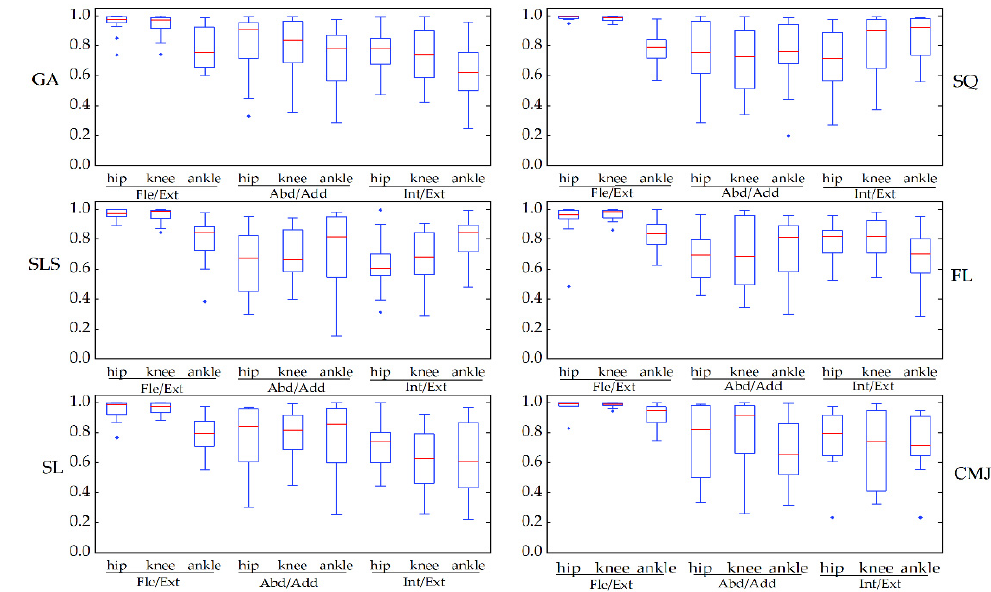
Figure 6. The waveform similarity between Perception Neuron ® system and OptiTrack system data after offset removal (CMC2) was assessed using box-and-whiskers plots of CMC values in the gait (GA), squat (SQ), single-leg squat (SLS), side lunge (SL), forward lunge (FL), and counter-movement jump (CMJ). Fle/Ext stands for “Flexion/Extension”, Abd/Add for “Abduction/Adduction”, and Int/Ext for “Internal/External Rotation”.